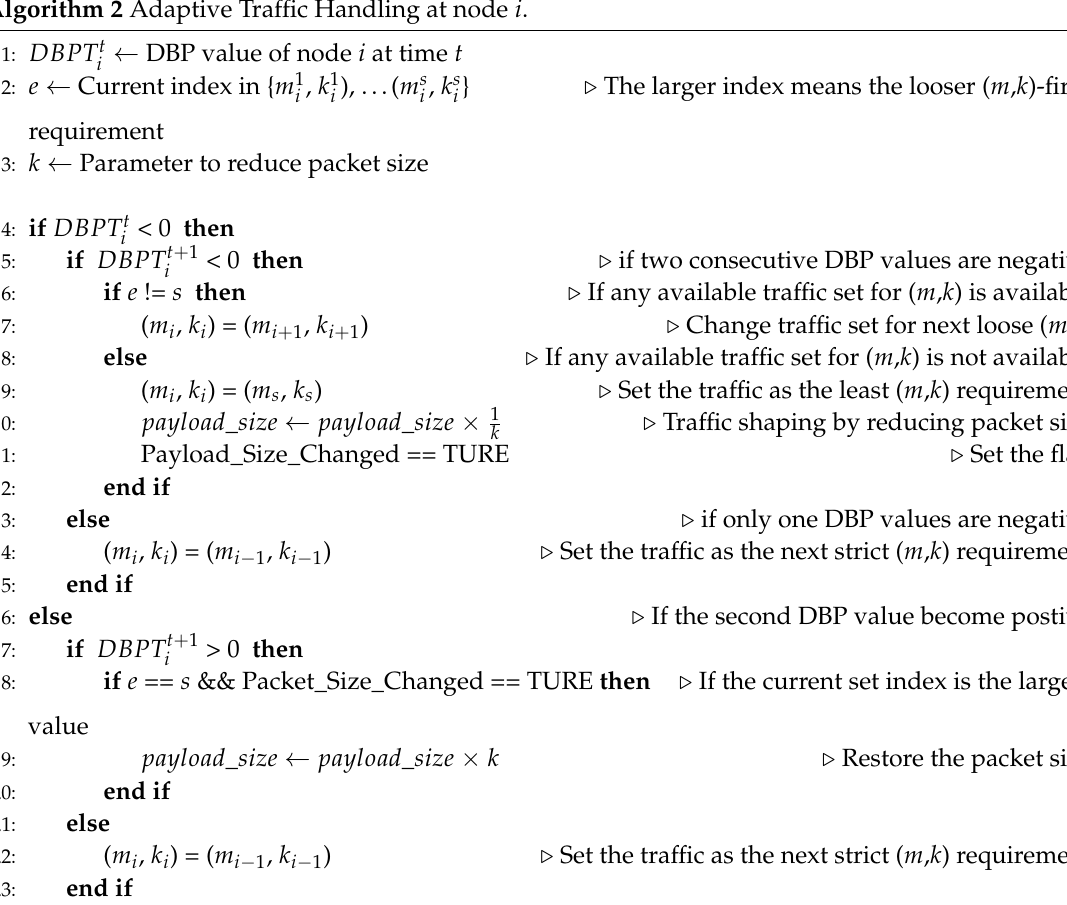
Algorithm 2 Adaptive Traffic Handling at node i